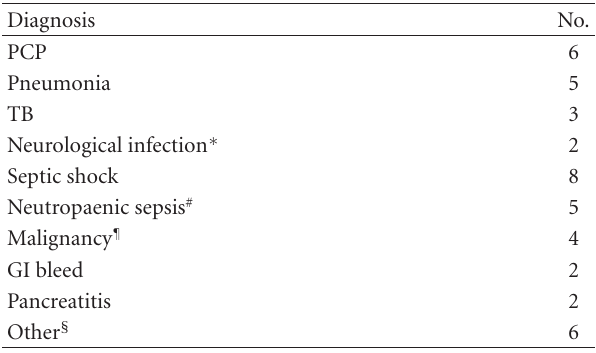
Table 3: Diagnoses resulting in the need for ICU admission among the patients included in this